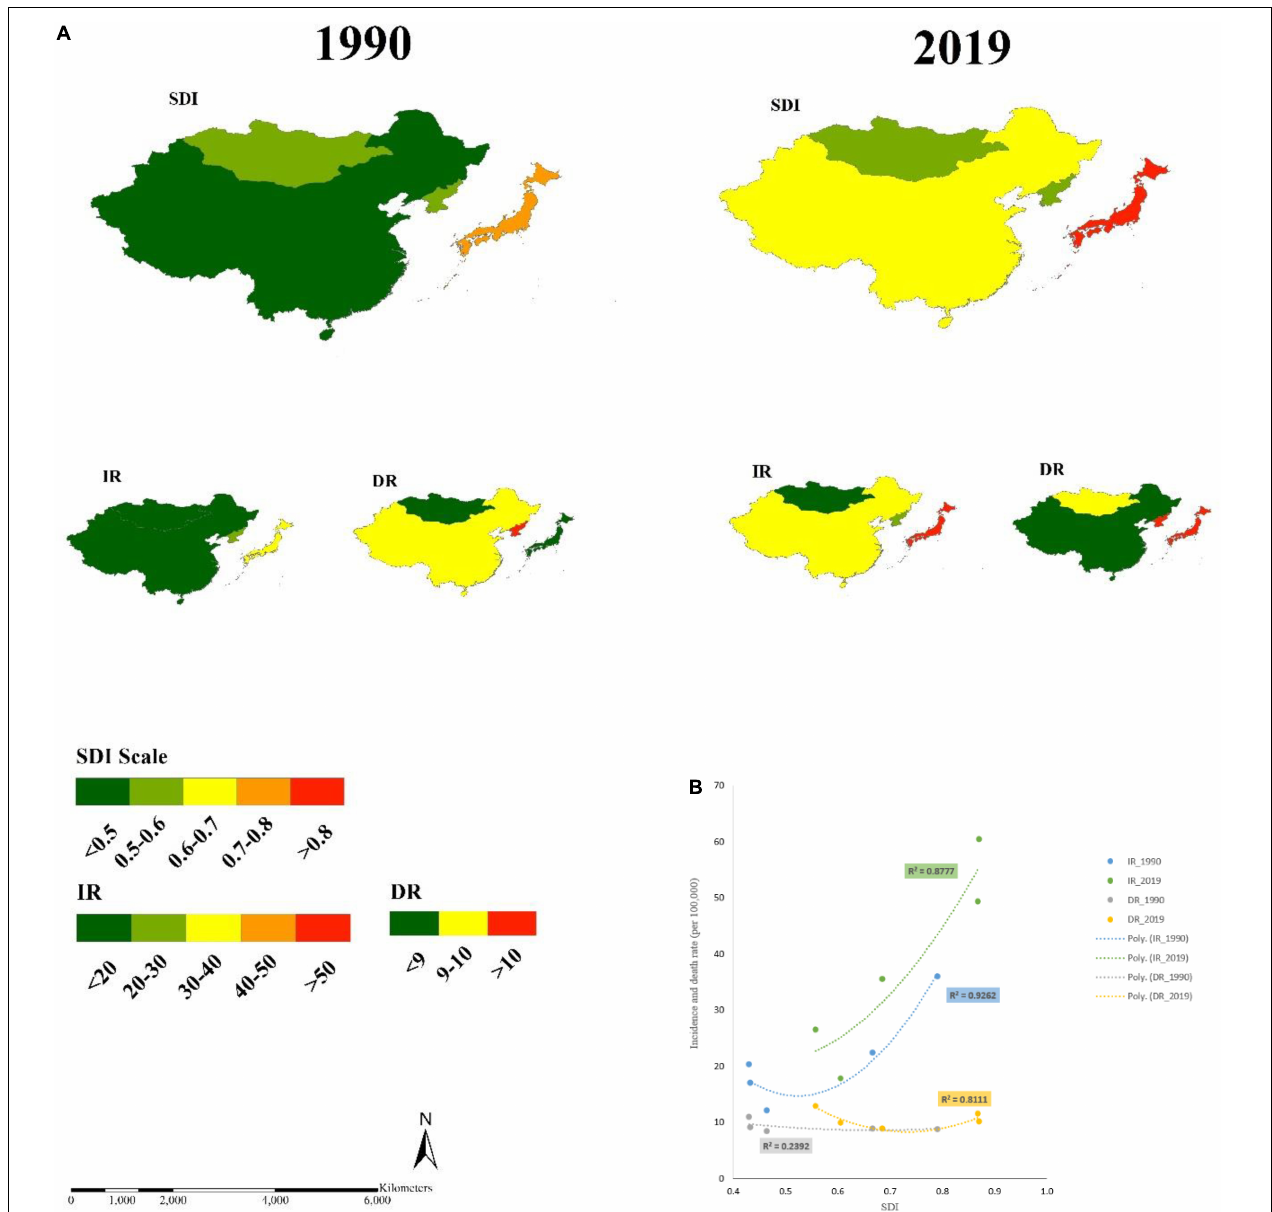
FIGURE 3 | The relationship between SDI, and IR, and DR for female BC in East Asia, 1990 and 2019. (A) The link between SDI and DR for female BC, 1990 and 2019; (B) The strength of relationship between SDI and IR and DR of BC in East Asian female, 1990 and 2019; SDI, sociodemographic index; BC, breast cancer (rates per 100,000); IR, incidence rate; DR, death